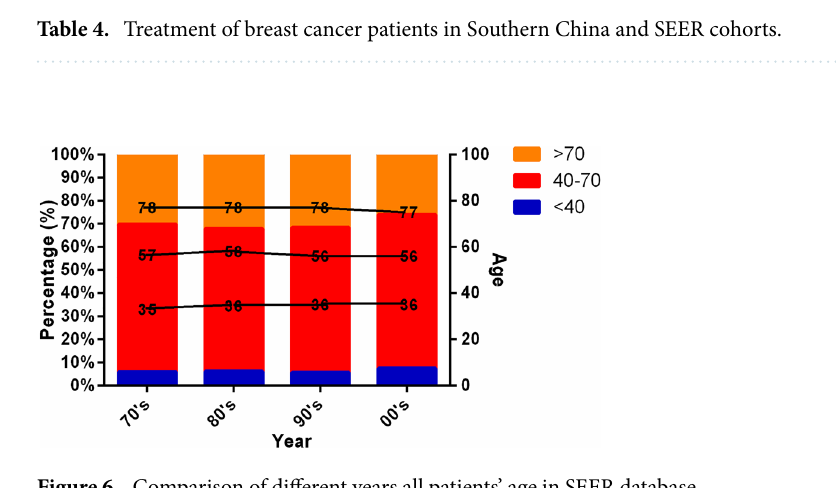
Figure 6. Comparison of different years all patients’ age in SEER